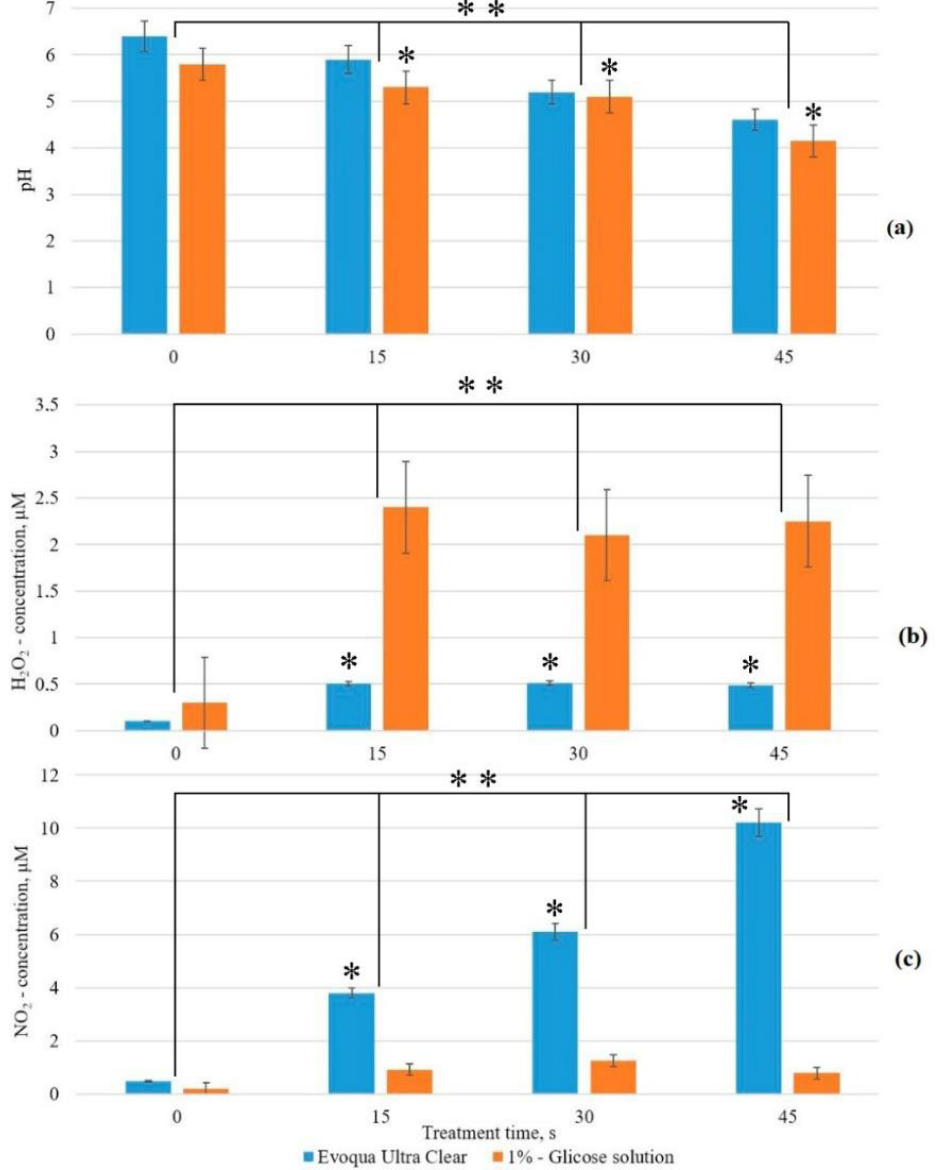
Figure 7. Change in pH of solutions ( a ); generation of H 2 O 2 ( b ); and NO 2 − ( c ) when exposed to CAP using Evoqua Ultra Clear water and 1% sucrose aqueous solution for 15, 30 and 45 s. * Indicates a significant difference at 5% level in comparison with the Evoqua Ultra Clear group with 1% sucrose solution group at same treatment time ( p < 0.05, Mann–Whitney U test). ** Indicates a significant difference at 5% level in comparison with the control (treatment time: 0 s).